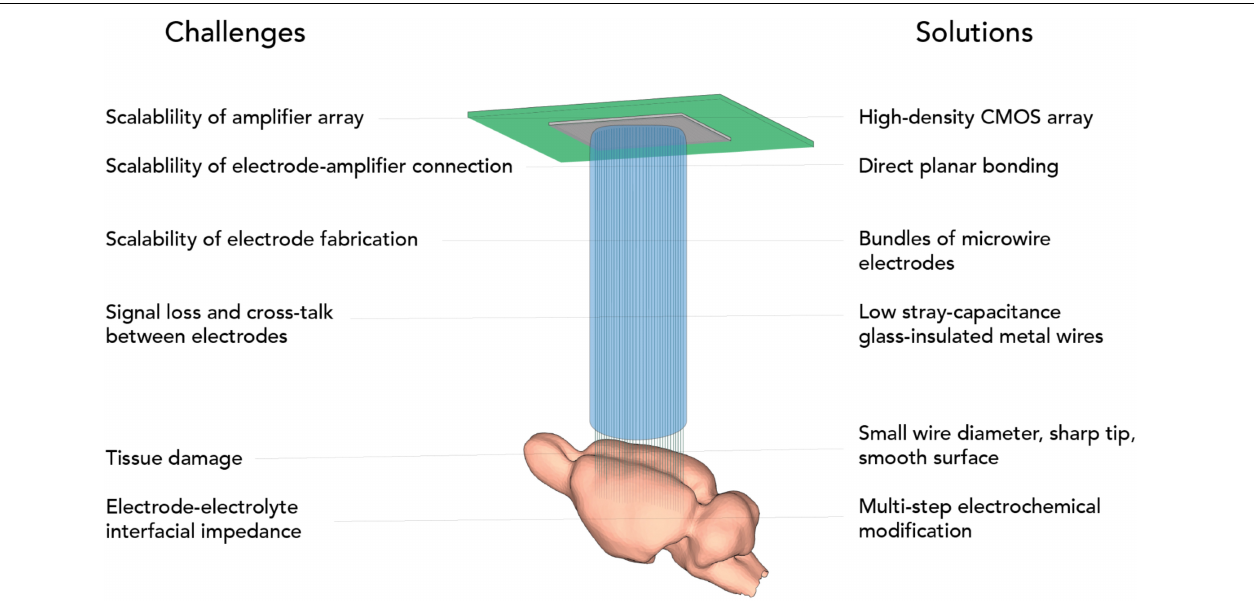
FIGURE 1 | Challenges of scalable electrophysiology addressed by